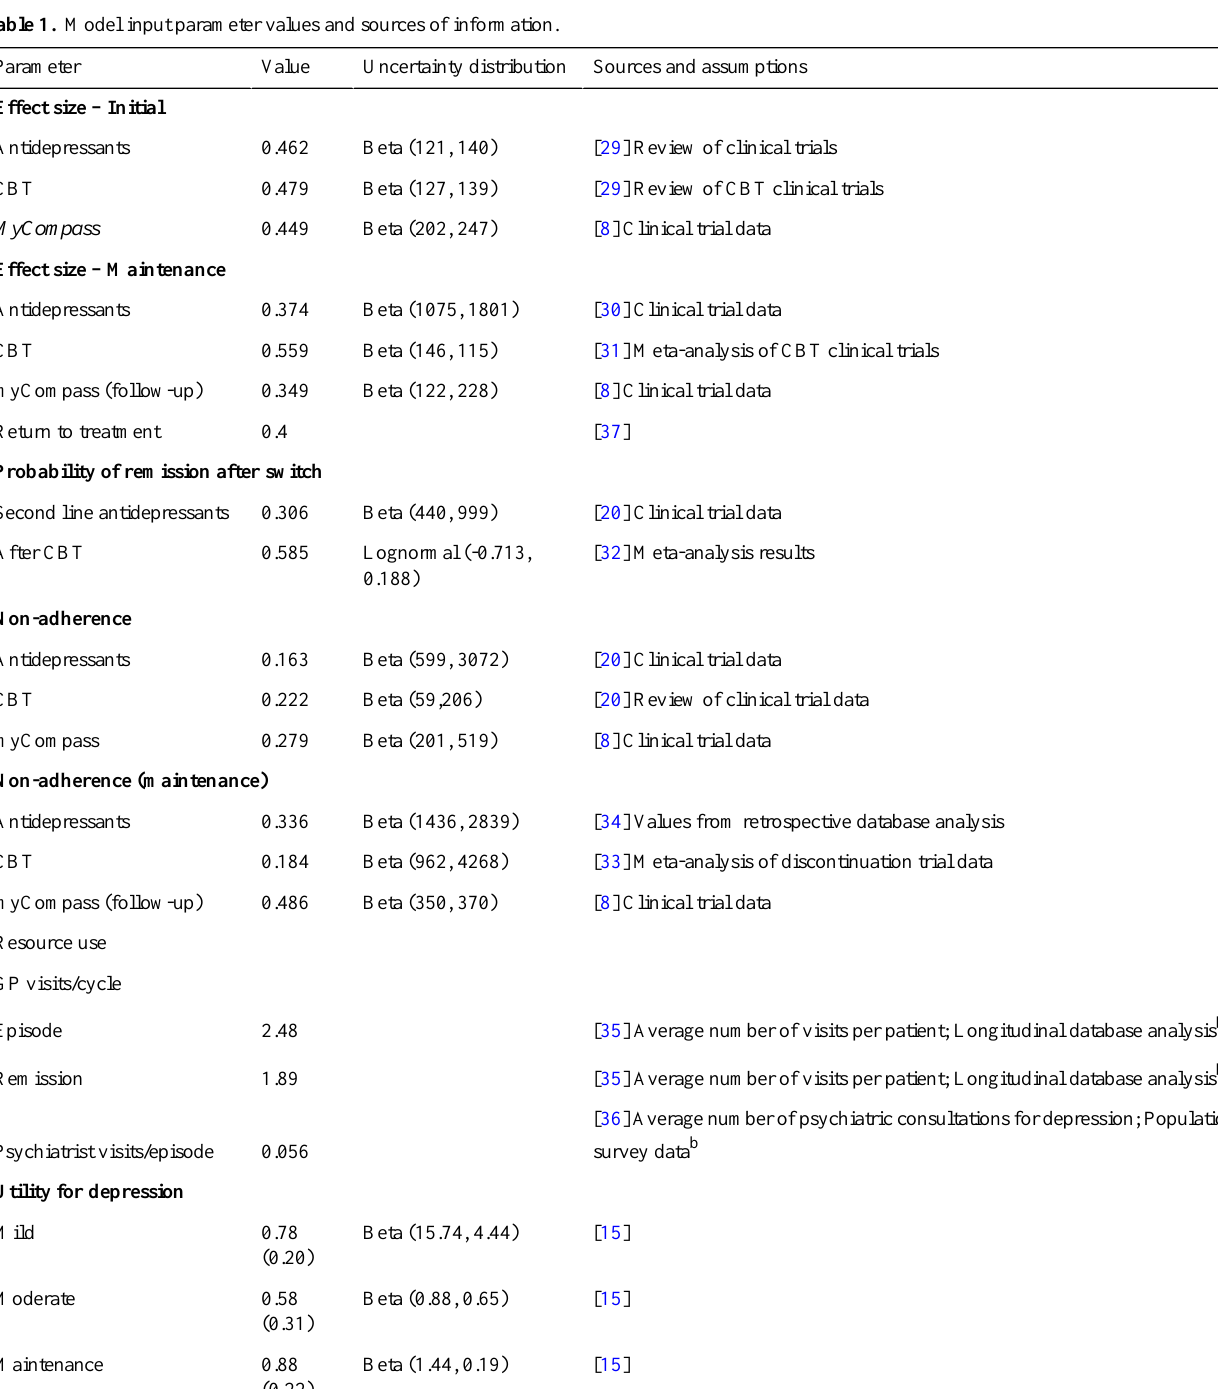
Table 1. Model input parameter values and sources of